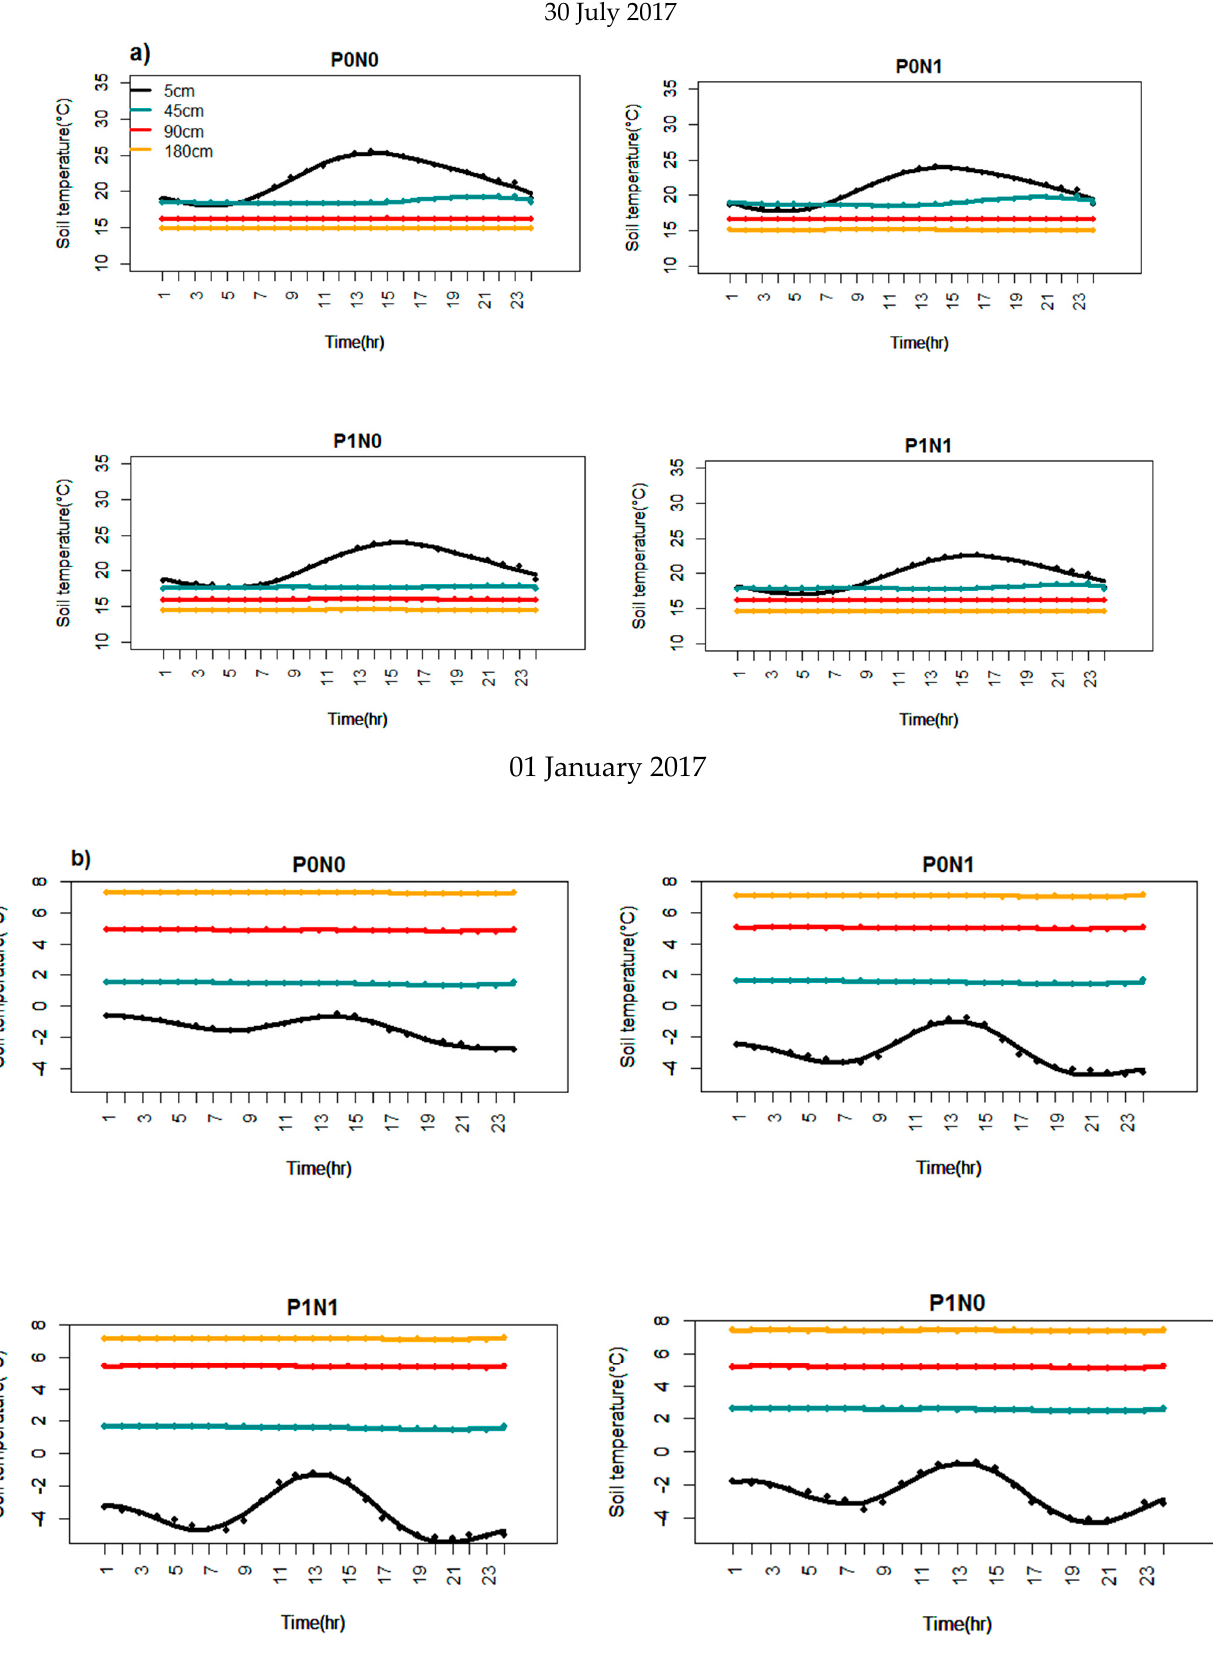
Figure 2. Soil temperature variation for the ( a ) hottest day and ( b ) coldest day under different managements over the studied years.